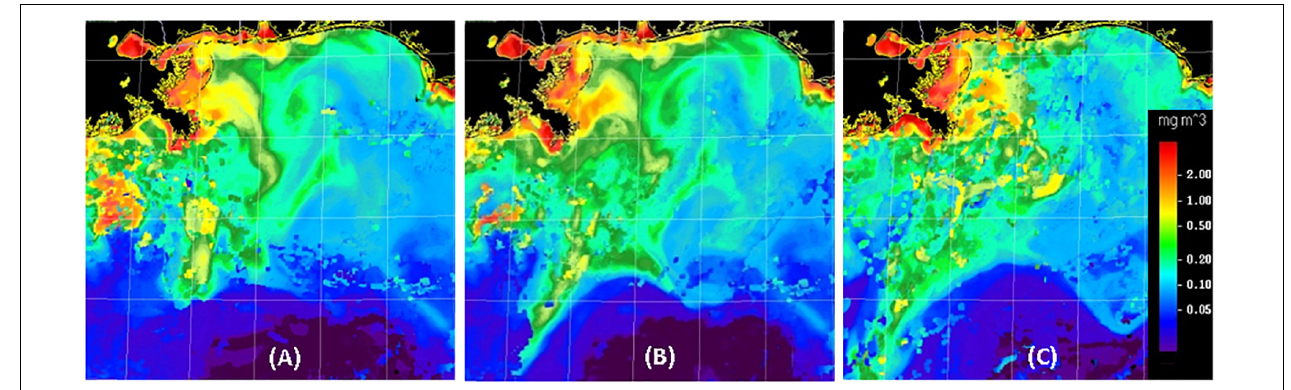
FIGURE 3 | Examples of MODIS ocean-color composite images created for the DEEPEND study region (26–30 ◦ N, 85–91 ◦ W) during DP06 ( A–C for July 22, 25, and 30, 2018, respectively). Imagery from several days was combined to emphasize recent surface feature locations. In agreement with HYCOM model predictions, features in the left portion of these images tended to move toward the southwest at more than 20 km per day, while features in the lower central portion of the images were influenced by the Loop Current and moved to the east-southeast at about 50 km per